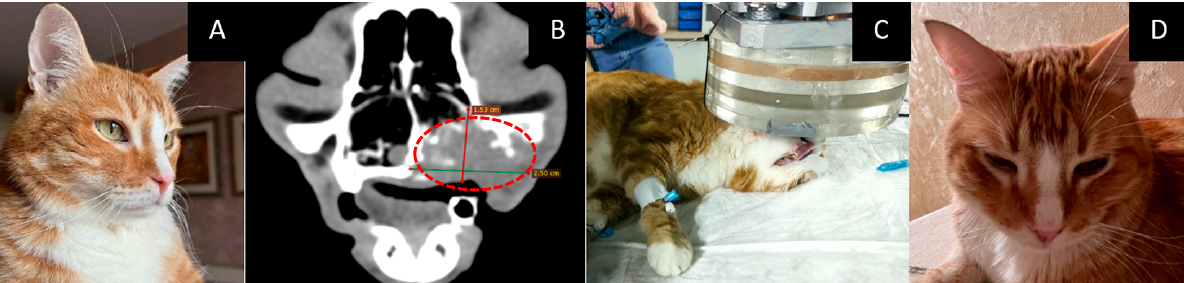
Figure 4. Male cat “Lev” (11 years old) with highly differentiated squamous cell carcinoma of the oral cavity and upper jaw on the right side and metastasis to the submandibular lymph node. Animal appearance ( A ) and head CT ( B ) before irradiation with a tumor in the oral cavity 25 × 40 × 15 mm in size (green and red lines, dashed red circle). Animal positioning under the lithium target during GdNCT ( C ) and animal appearance after irradiation ( D ). Active tumor progression was found three months after irradiation.